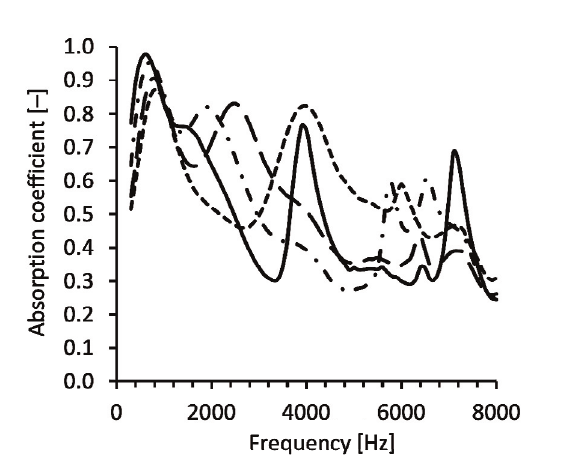
Fig. 14. Double-layer set-up for material A. Distance X1 was set to 30 mm and distance X2 was varied from 5 mm (dashed line) to 50 mm (solid line).